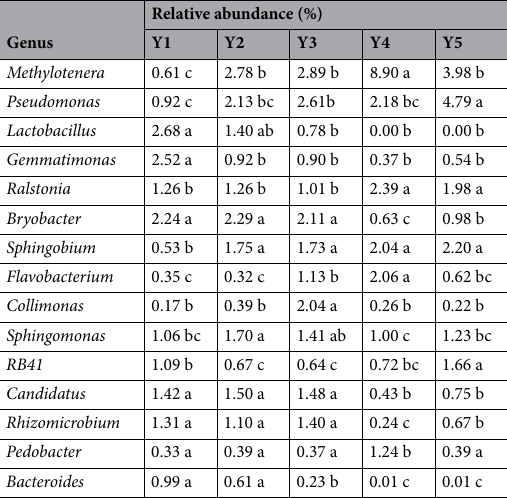
Table 3. Relative abundance (%) of bacterial genera in the samples with different cultivation years. Different lower-case letters indicate significant differences ( p < 0.05) among the 5